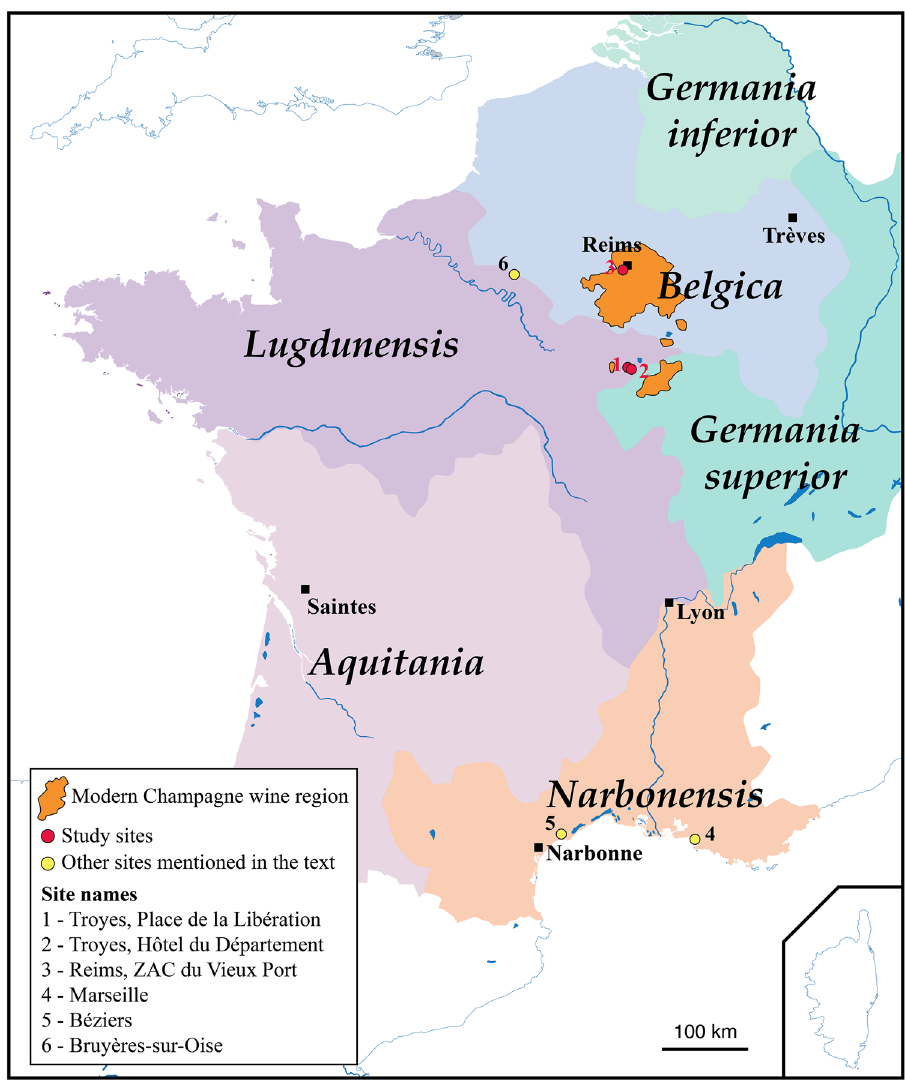
Figure 1. Gaul during the first century